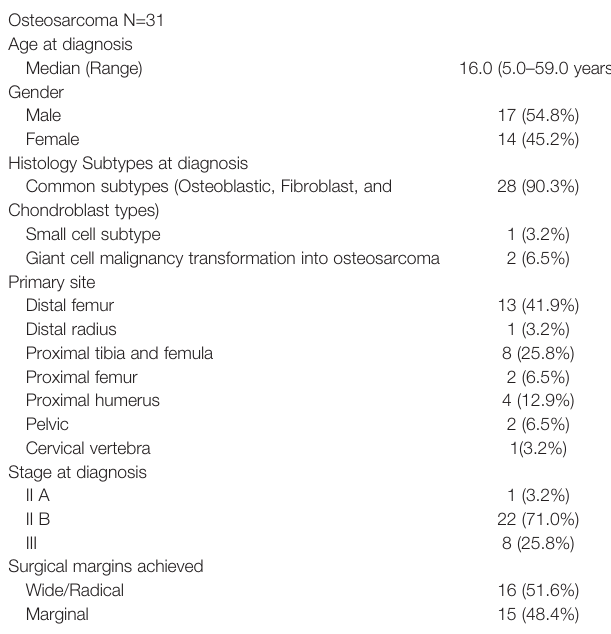
TABLE 1 | Baseline patient and tumor